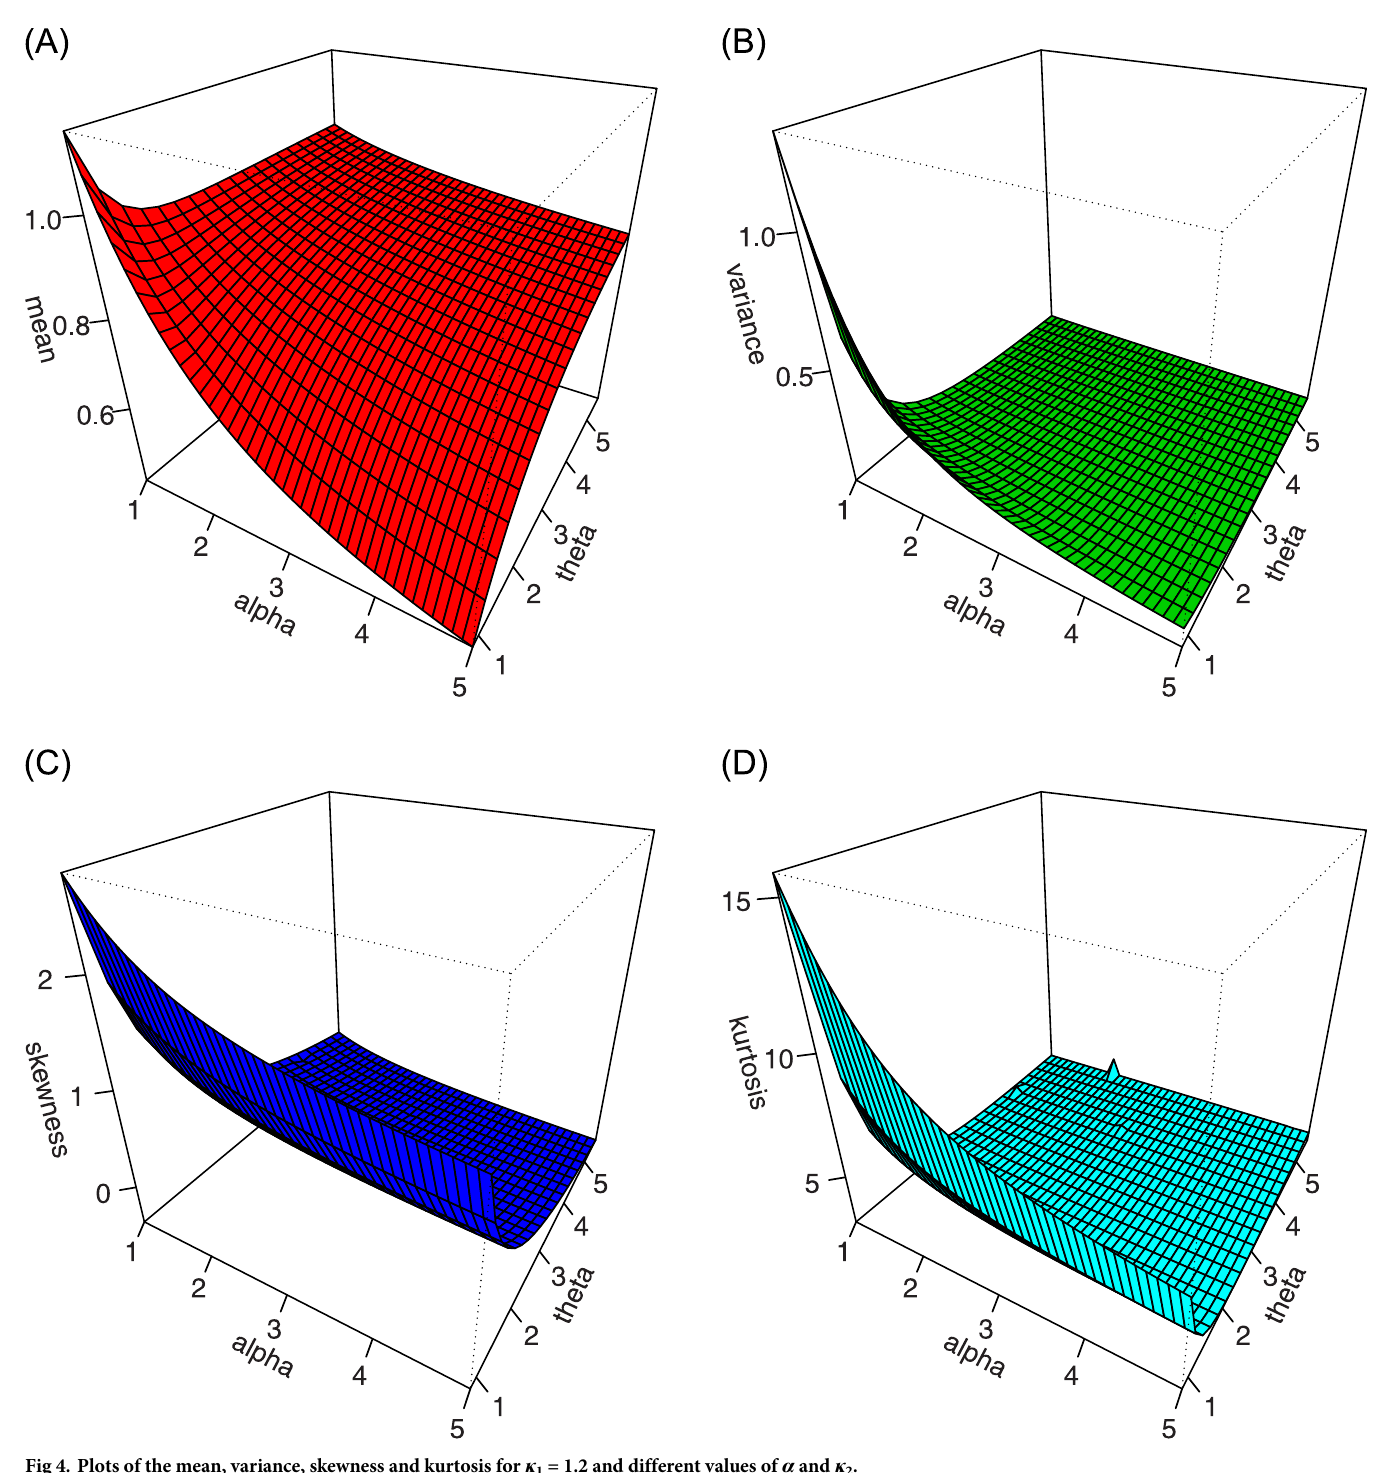
Fig 4. Plots of the mean, variance, skewness and kurtosis for κ 1 = 1.2 and different values of α and κ 2 .